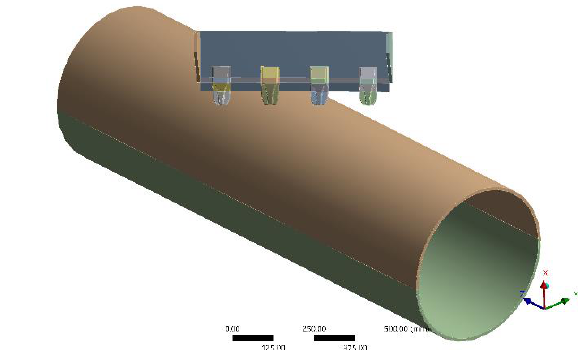
Figure 9. Variants in the excavator bucket positioning in relation to the pipeline axis: ( a ) bucket in the pipeline axis, ( b ) bucket perpendicular to the pipeline axis and ( c ) bucket rotated by 45 ◦ in relation to the pipeline axis.